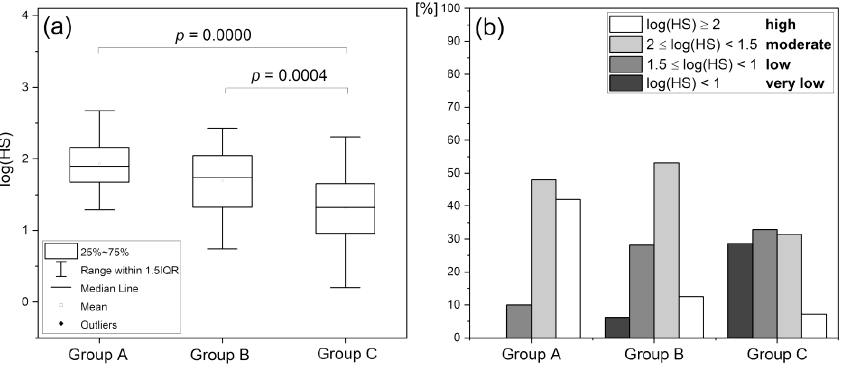
Figure 7. Assessment of log(HS) parameter in various groups: A – highly trained endurance athletes; B – healthy middle-aged individuals; C – diabetes type 2 patients; ( a ) statistical differentiation (one-way ANOVA with the Scheffe post hoc test) of groups A, B, and C based on the log(HS) parameter; ( b ) distribution of the log(HS) parameter [43]. Based on: Katarzynska, J.; Zielinski, J.; Marcinek, A.; Gebicki, J. New Approach to Non-Invasive Assessment of Vascular Circulation Based on the Response to Transient Ischemia. Vasc. Health Risk Manag. 2022 , 18 , 113–116; DOI:10.2147/VHRM.S358983, Dove Medical Press Ltd. publisher.